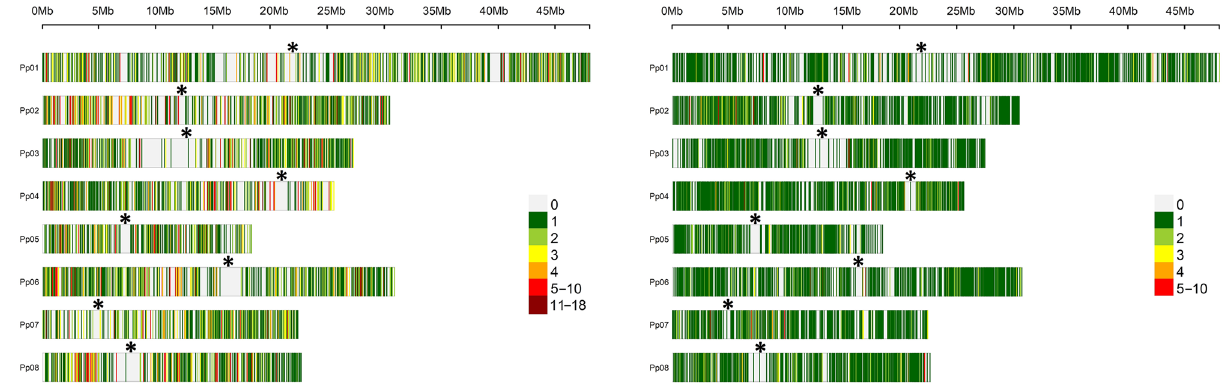
Figure 7. Density of SNPs along chromosomes. Number of SNPs within 1 Kb window size for the 7967 SNPs obtained with the platform developed (left) and the Ilumina 9 K SNP array (Verde et al. 5 , right) are shown. Vertical bar at the corners indicates the color assigned to the SNP number per 1 Kb window. The asterisks (*) indicate the putative location of